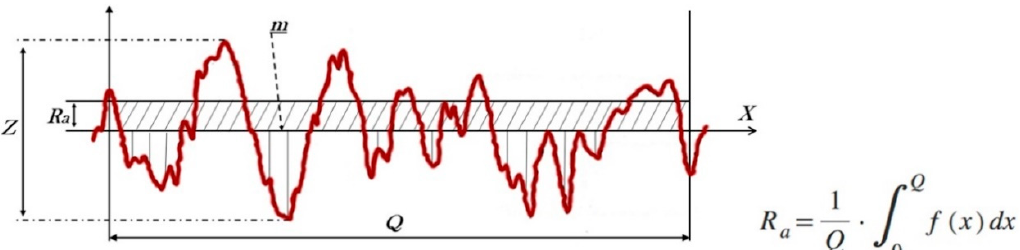
Figure 2. Representative scheme of the parameters measurement ( S a , R a and Z ) on the surface samples and the arithmetic average roughness calculation of the R a .